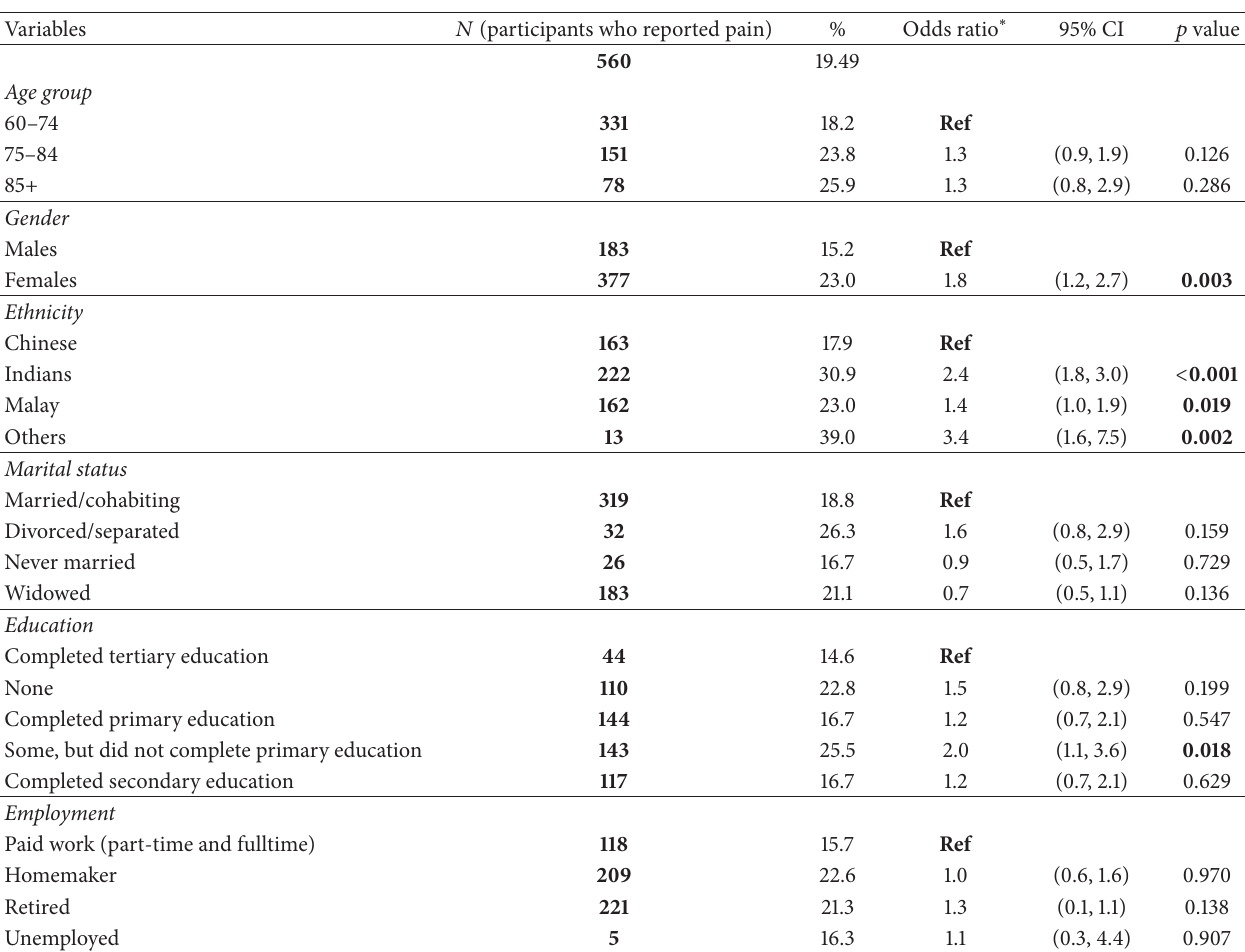
Table 1: Sociodemographic correlates of